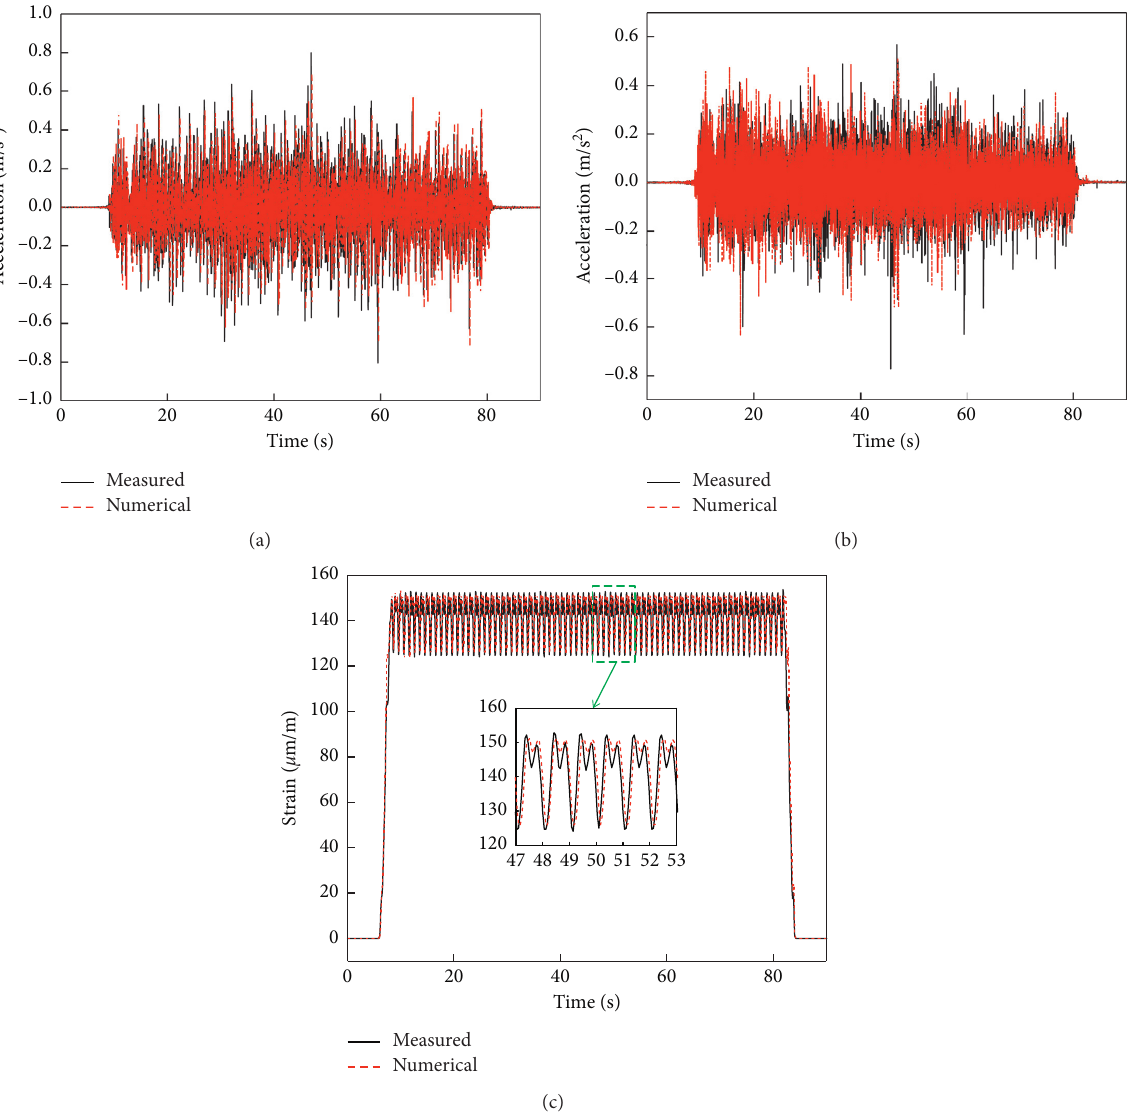
Figure 12: Time histories for the DR of the bridge girders’ mid-span section: (a) vertical acceleration; (b) lateral acceleration; (c)